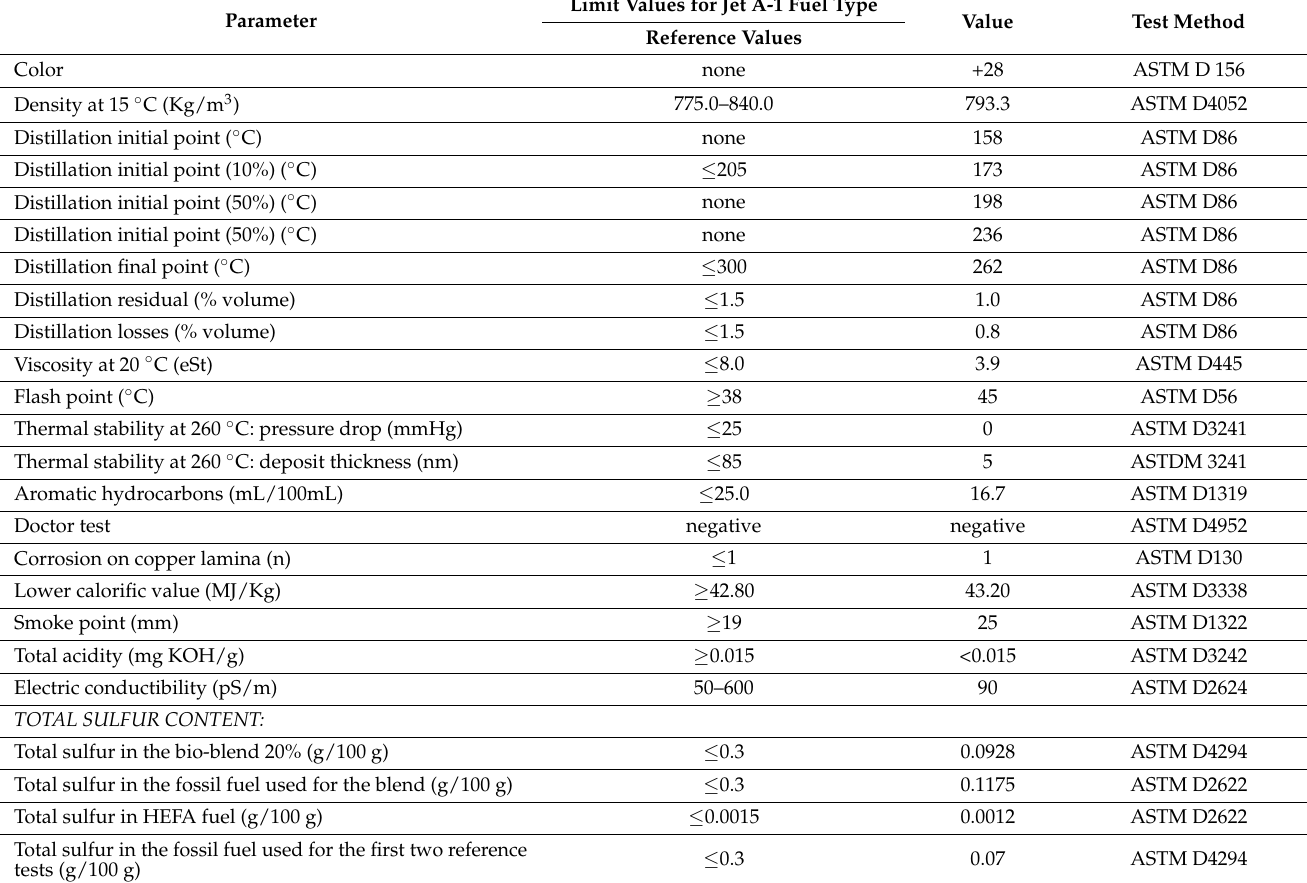
Table A1. Chemical and physical characterization of bio-blend fuel 17% and content of sulfur in the bio-blend and fossil fuels used for reference test and blend